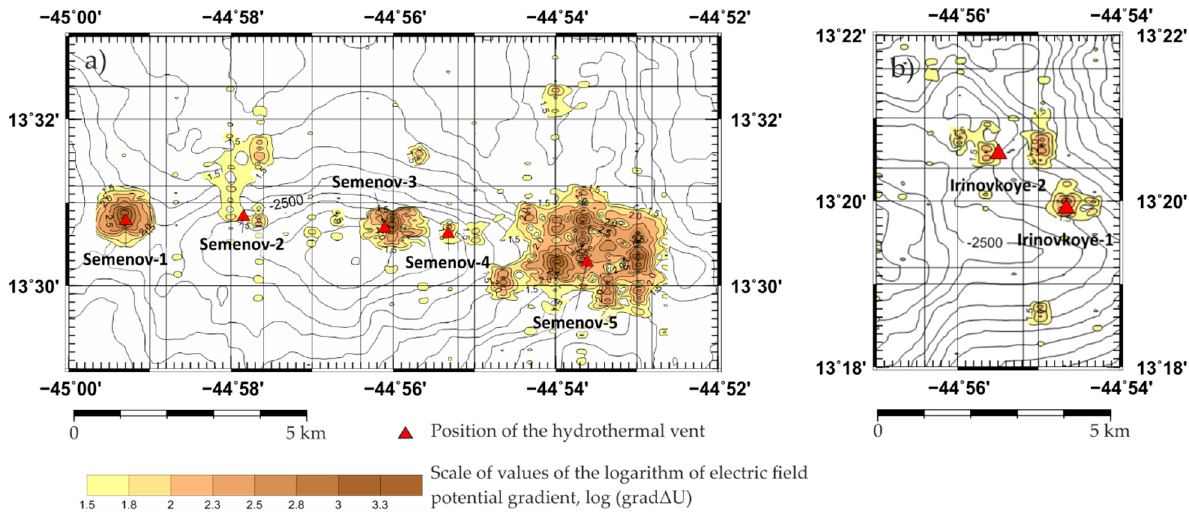
Figure 2. Schemes of isolines of the logarithm of the gradient Δ U: ( a ) the Semenov hydrothermal cluster; ( b ) the Irinovskoye HF.